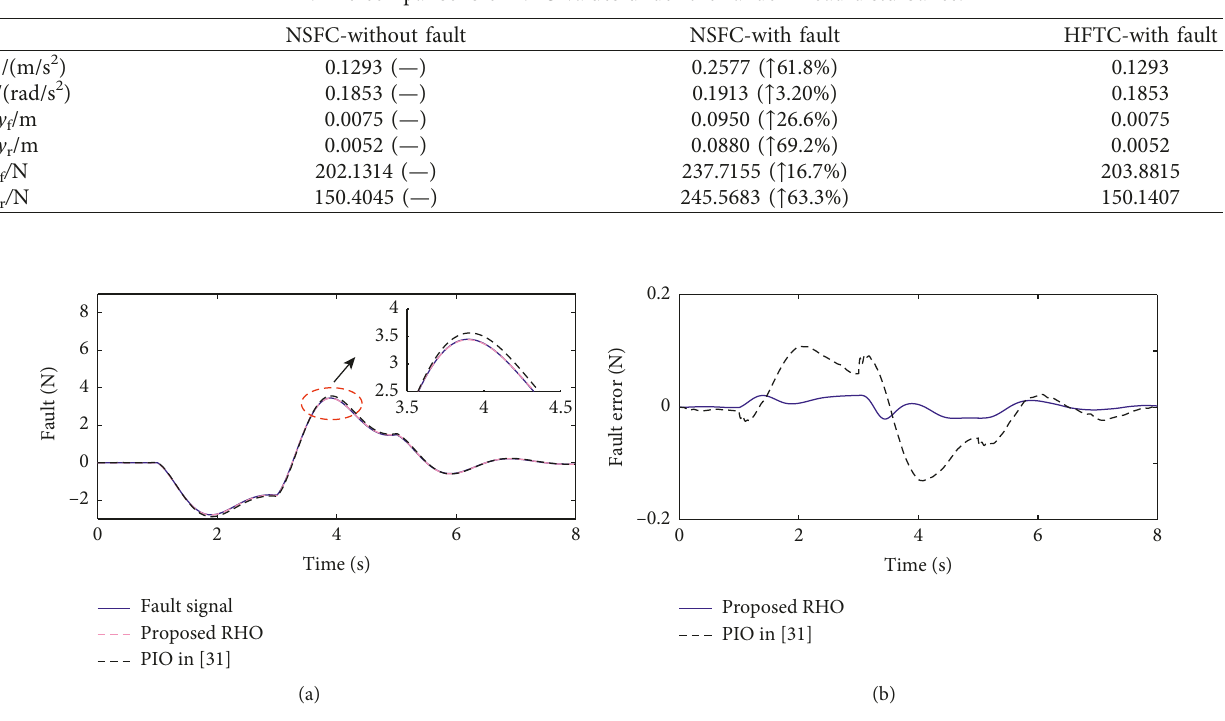
Figure 8: The control forces of (a) the front actuator and (b) rear actuator under the random road disturbance. Table 2: The comparisons of RMS values under the random road disturbance.